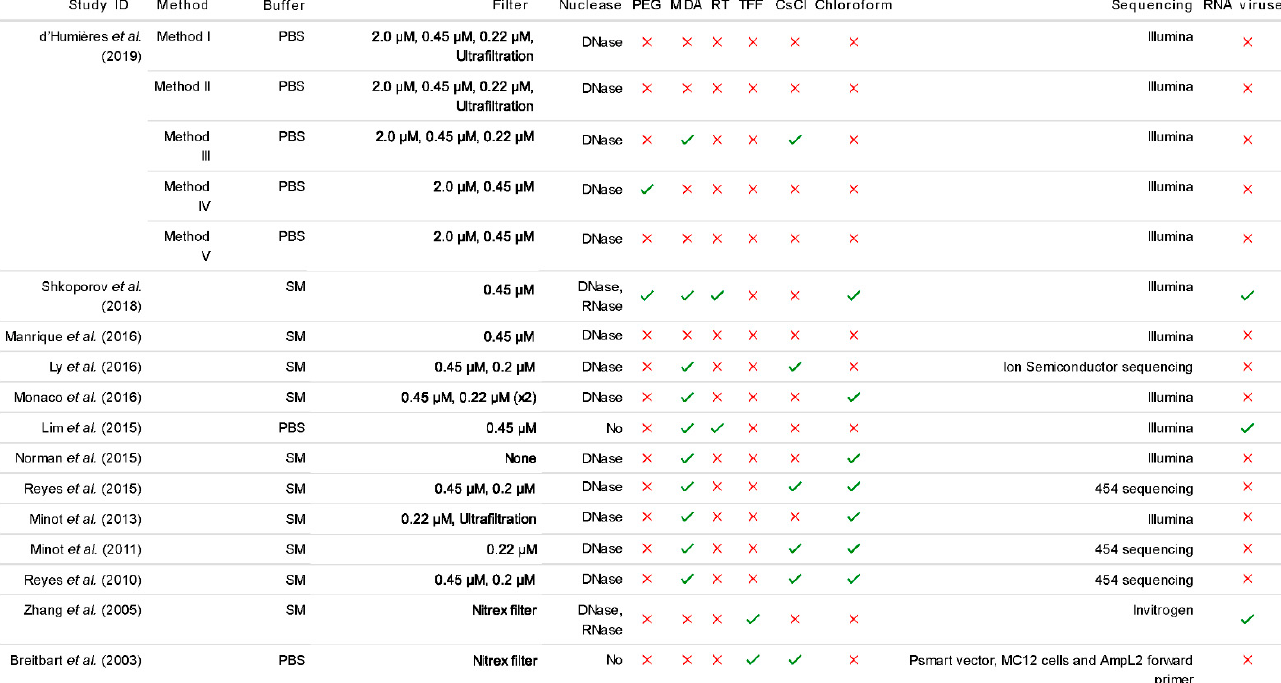
Figure 2. Summarised extraction method comparisons from a selection of recent human gut virome papers. All studies included in this review analysed the composition of the human gut virome based on faeces as the starting material [2,7,8,26–28,38,54,58,60,64–66]. The different sample handling methods, procedure for extracting the VLP fraction and sequencing technology are examined. In the 2019 study by d’Humières et al . , method I includes ultrafiltration whereas method II involves both ultrafiltration and ultracentrifugation. (See Supplementary Material for data).